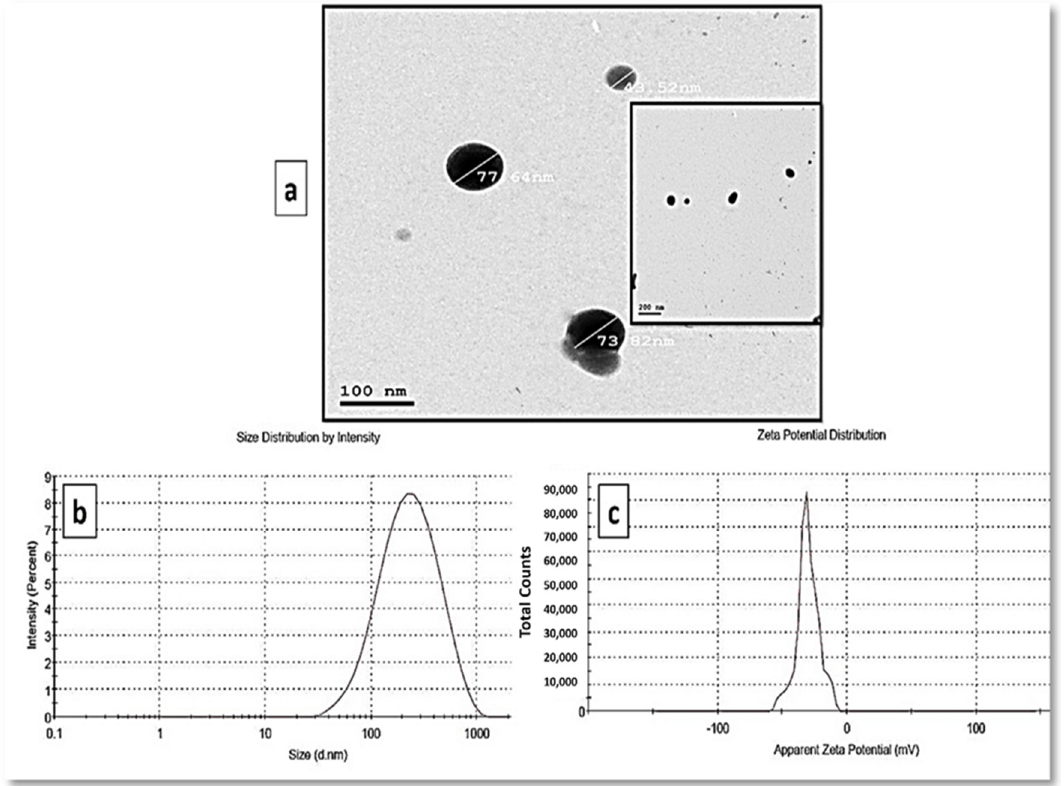
Figure 3. Morphological characterization of myco-synthesized SeNPs ( a ) TEM photographs of myco-synthesized selenium nano-selenium using P. chrysogenum culture filtrate at the scale of 100 nm and 200 nm, ( b ) size distribution pattern, and ( c ) zeta potential distribution. The XRD results revealed a broad pattern with no clear Bragg peaks. While there were no significant peaks, smaller peaks at 2 Ѳ values were found at 12.658°, 19.146°, 20.712°, 21.011°, 25.352°, 29.402°, 31.830°, 53.938°, 55.218°, 58.039°, and 61.540°. The results